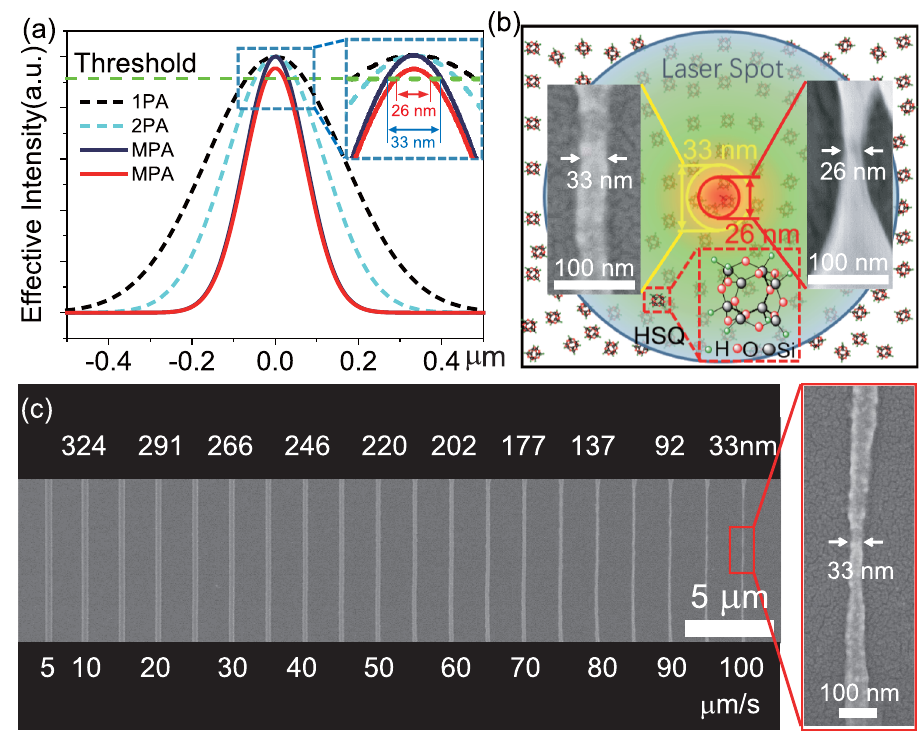
Fig. 2 The construction of nanoscale HSQ features by FsLDW. a Illustration of patterning HSQ with sub-diffraction feature size by FsLDW through nonlinear absorption process. The dashed green line denotes the threshold value of the fs laser induced polymerization. b Scheme of HSQ features fabricated by FsLDW with single-scanning method and cross-scanning method, resulting in 33 nm and 26 nm feature sizes, respectively. When the laser intensity increases, only a portion of the laser spot exceeds the threshold for polymerization, enabling the creation of sub-diffraction features. The blue circle represents the fs laser focus spot size. The inset is the molecular structure of HSQ. c SEM image of HSQ nanowires fabricated by FsLDW with different laser scanning speeds. The inset is the HSQ nanowire with the narrowest linewidth of 33